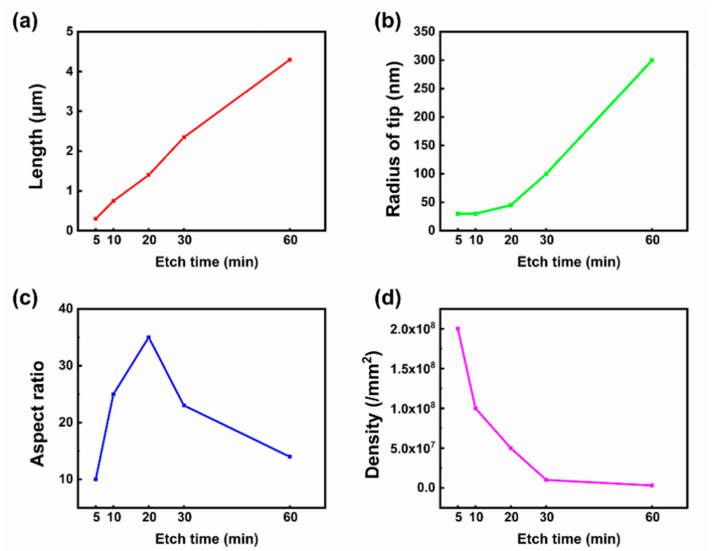
Figure 3. Plots of ( a ) length and ( b ) radius at the tip of a single nanocone under different etching times. ( c ) Plots of the aspect ratio of a single nanocone under different etching times. ( d ) Plots of density and etching time